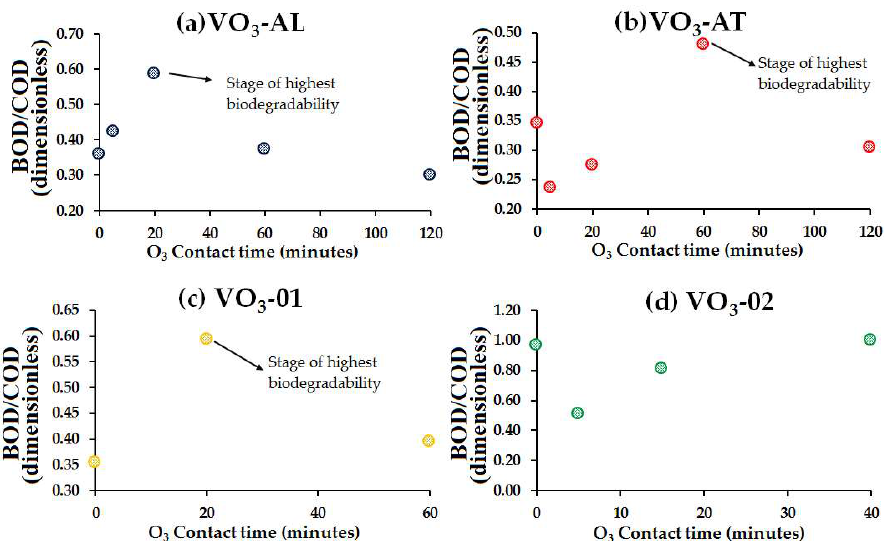
Figure 3. Removal (%) of COD, BOD 5 , Spectral Absorption Coefficient at 254 nanometers (SAC 254 ) and total solids (TS) upon ozonation of water at different ozone doses and O 3 contact time.